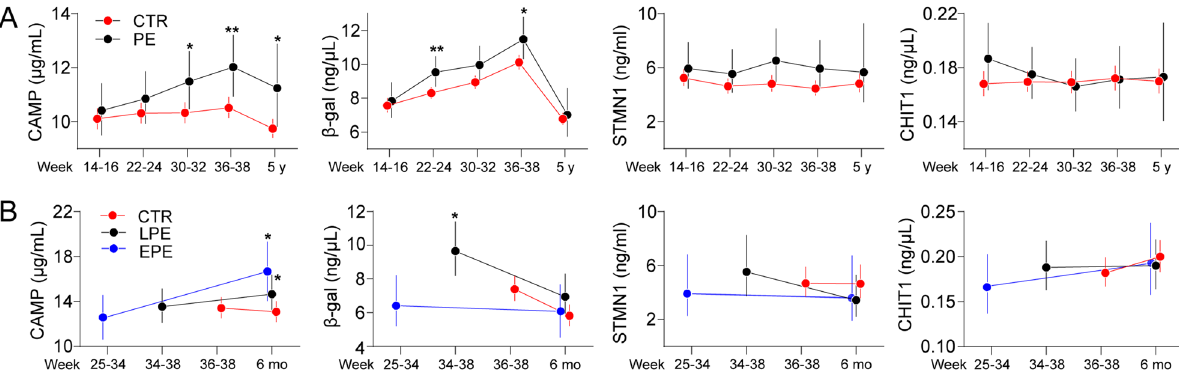
Figure 3. Temporal levels of circulating senescence markers during pregnancy and postpartum follow-up. ( A ) Levels of CAMP, β-galactosidase, STMN1 and chitotriosidase/chit1 during pregnancy and 5 years follow-up in the STORK cohort comparing controls and PE. ( B ) Levels of CAMP, β-galactosidase, STMN1 and chitotriosidase/chit1 during pregnancy and 6 months follow-up in the ACUTE PE cohort comparing controls and PE. * p < 0.05, ** p <